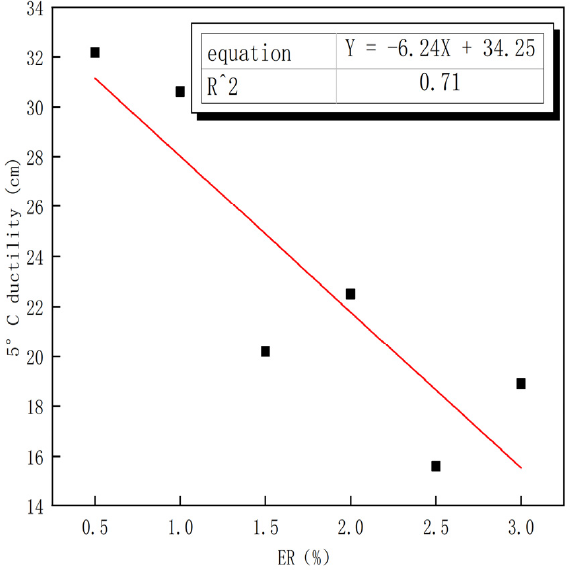
Figure 3. Relationship between ER content and low temperature ductility.